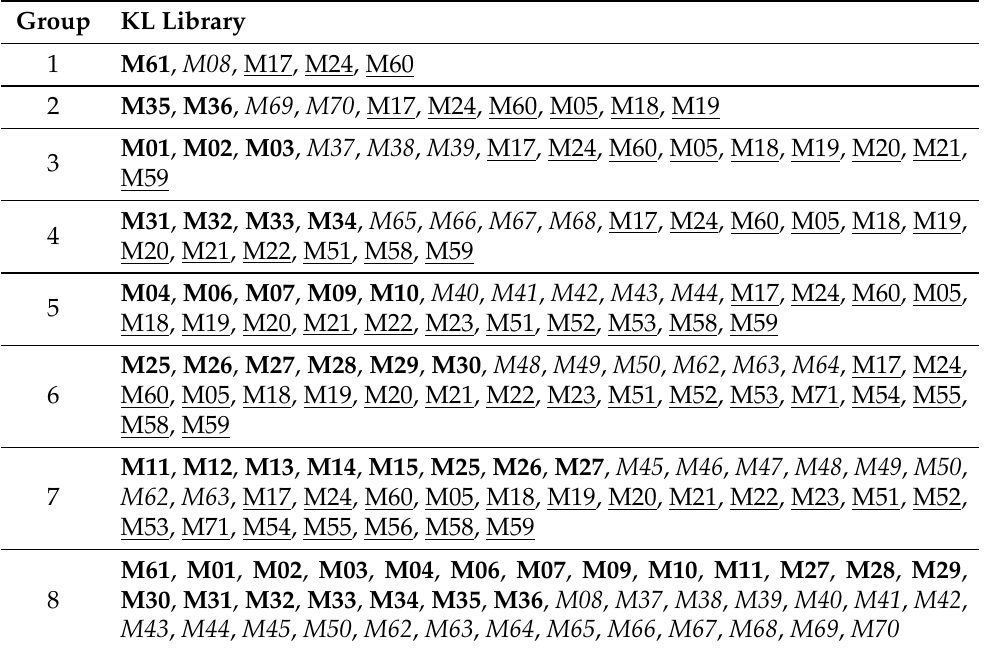
Figure 7. Tanimoto similarity matrix Table 4. Groups for the experiment. Each ligand belongs to some family [25]. The ligand structure specification is in Tables 1–3. The bold , cursive or underlined ligand belongs to the resorcinol , hydroxy-indazole or “others” family